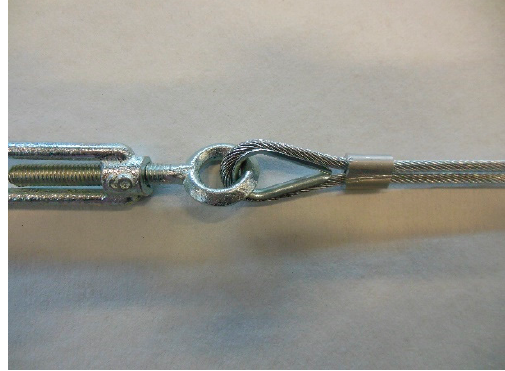
Figure 26. Specimen 1: Flemish eye closed by 1 ferrule.